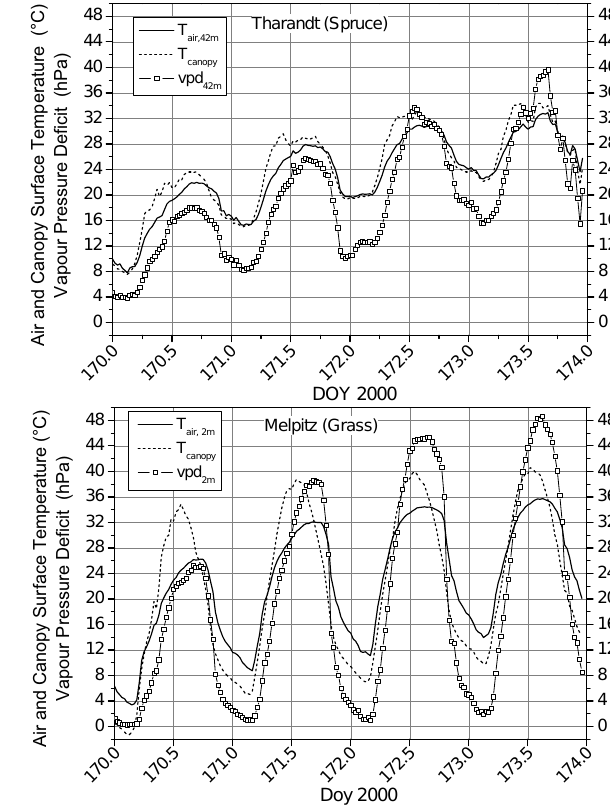
Fig. 5. Solar and Net Radiation at the Anchor Station Tharandt (Spruce, minor water limitation, panel above) and at the Melpitz ex- perimental site (Short Grass, strong water limitation, panel below) used for model input in HIRVAC during the investigation period 18 to 21 June 2000.